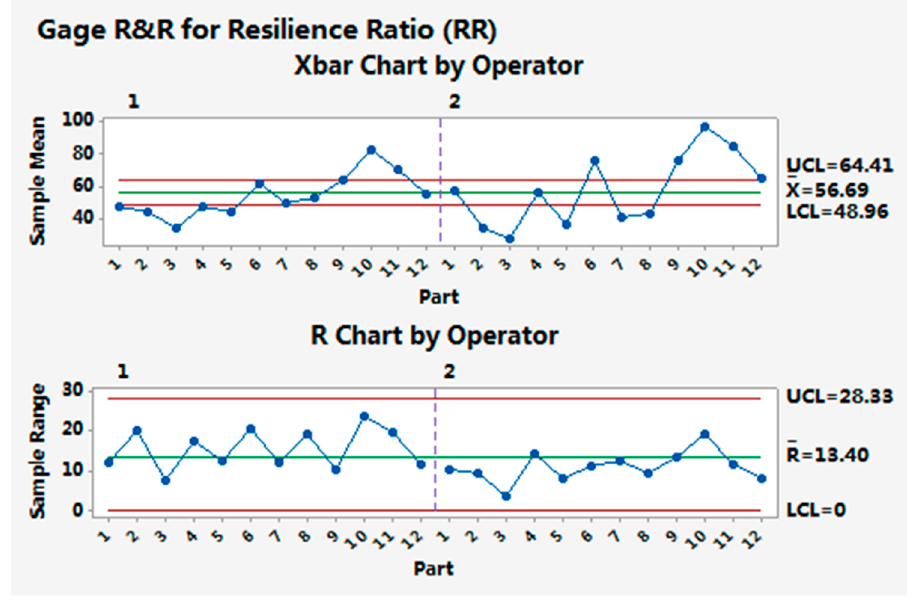
Figure 14. Gage capability result for the resilience ratio (RR).